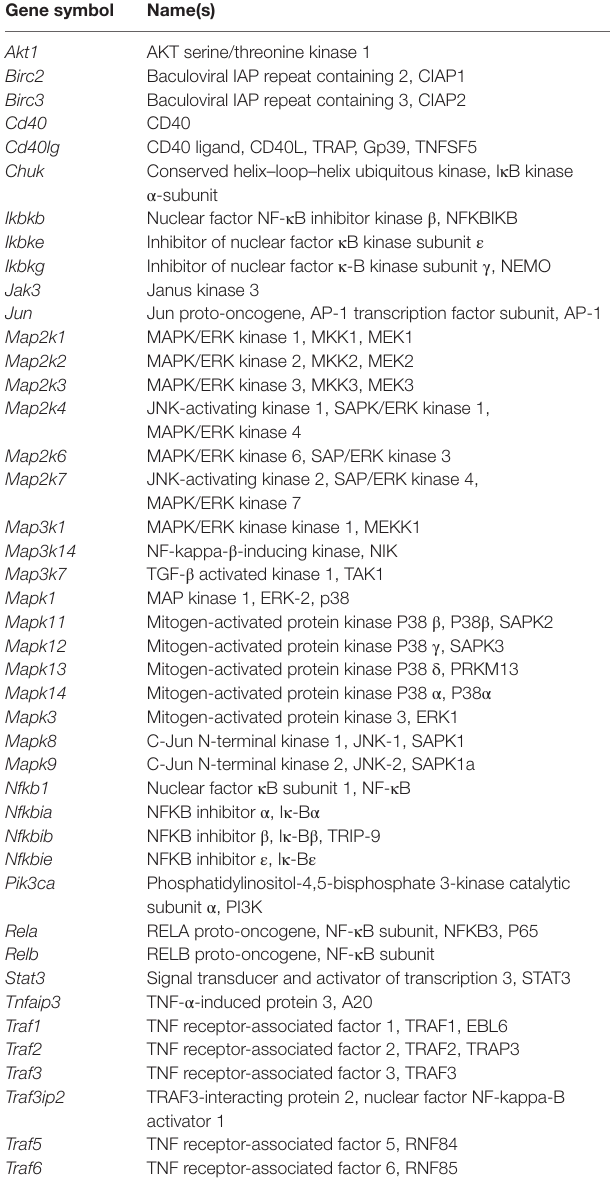
TABLe 3 | CD40-signaling core gene